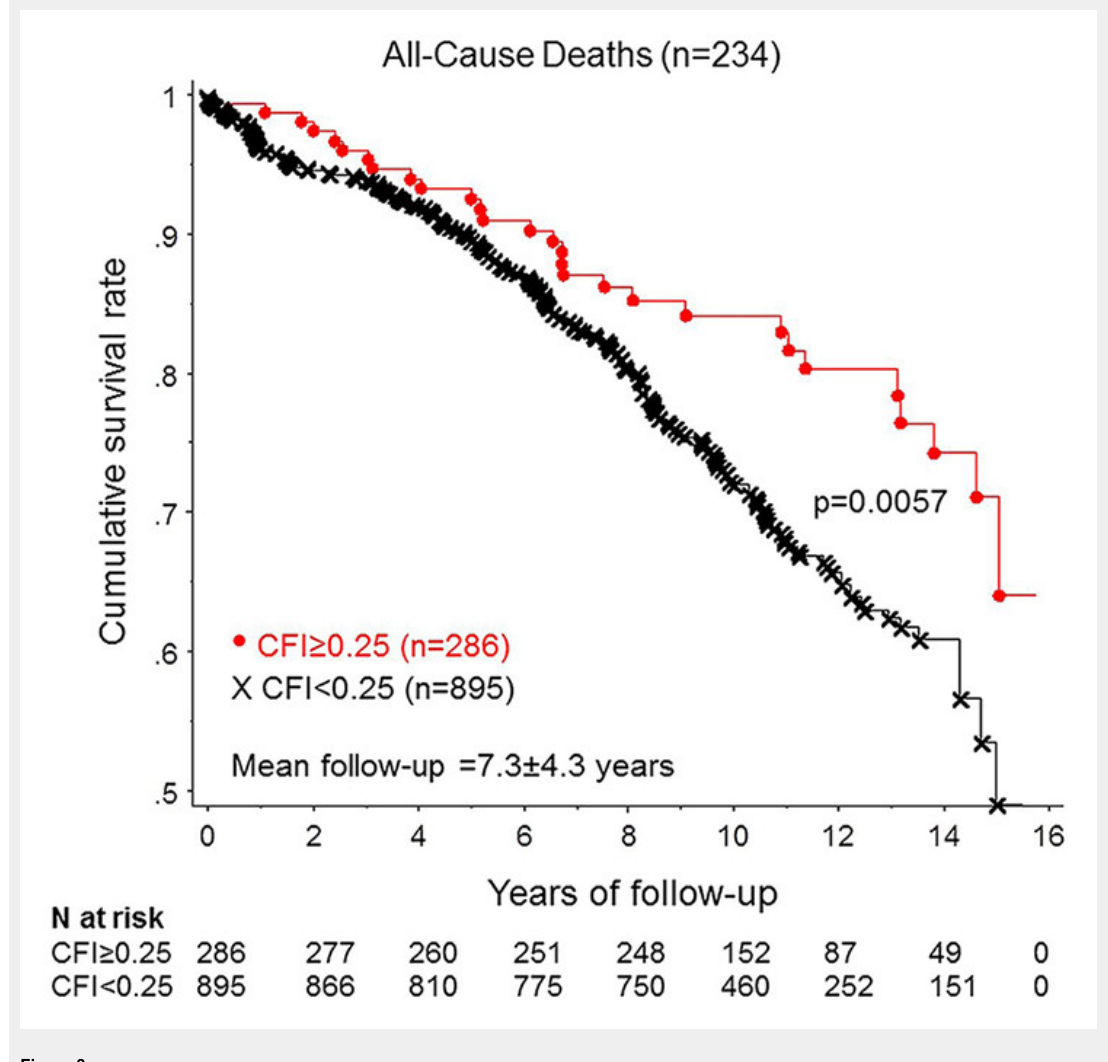
Figure 8 Cumulative survival rates in patients with low and with high collateral flow index (CFI). (Data from Seiler C, et al. Prognostic relevance of coronary collateral function: confounded or causal relationship? Heart. 2013;99(19):1408-14 [5], with permission from BMJ Publication Group